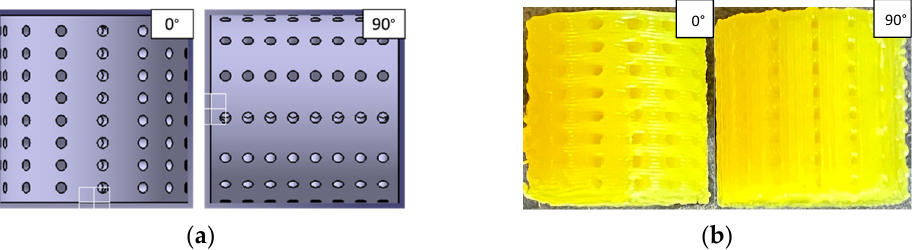
Figure 2. ( a ) Printing orientations (represented by the small crosswise model with circular pores); ( b ) printed scaffolds printed with 0° (left) and 90° (right) orientation.